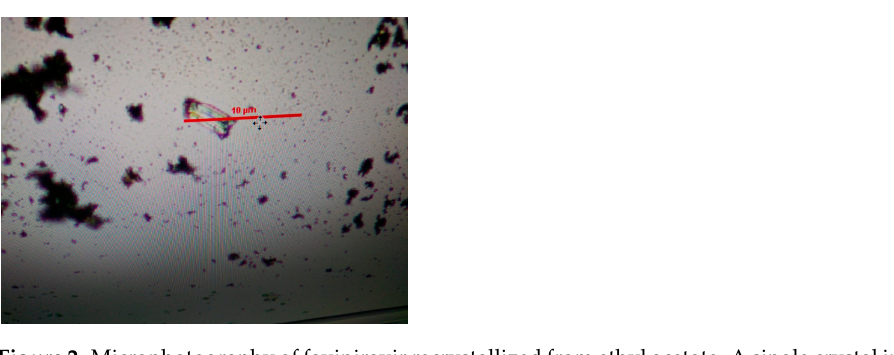
Figure 2. Microphotography of favipiravir recrystallized from ethyl acetate. A single crystal in the center corresponds to the impurity of the orthorhombic phase in mass of the tetragonal one.